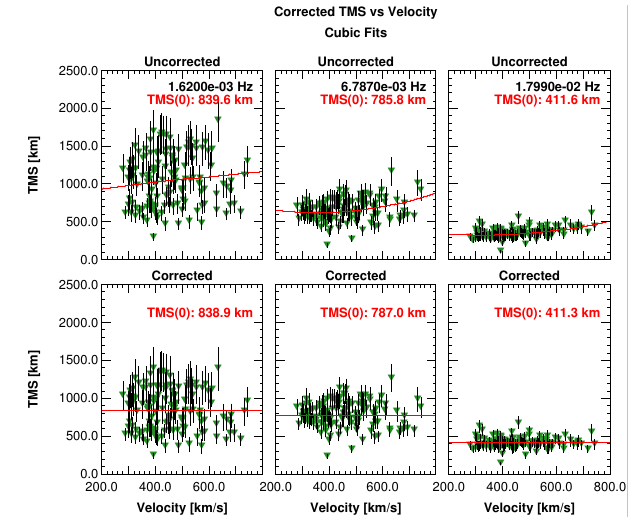
Fig. 9. Plots of λ T vs the solar wind speed for various cutoff frequencies. The plots show a very small dependence of λ T on velocity.